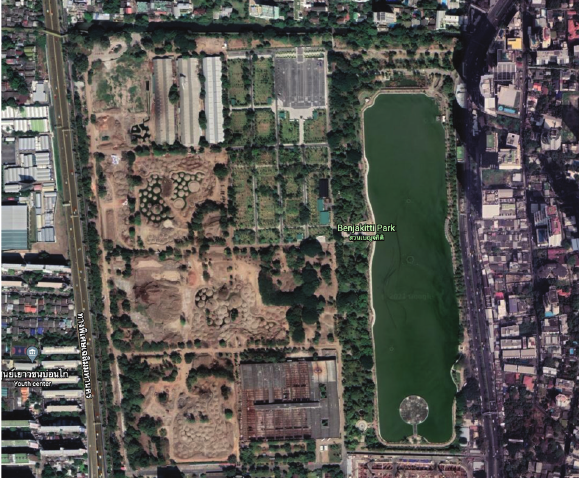
Figure 1. Satellite image of Benjakitti